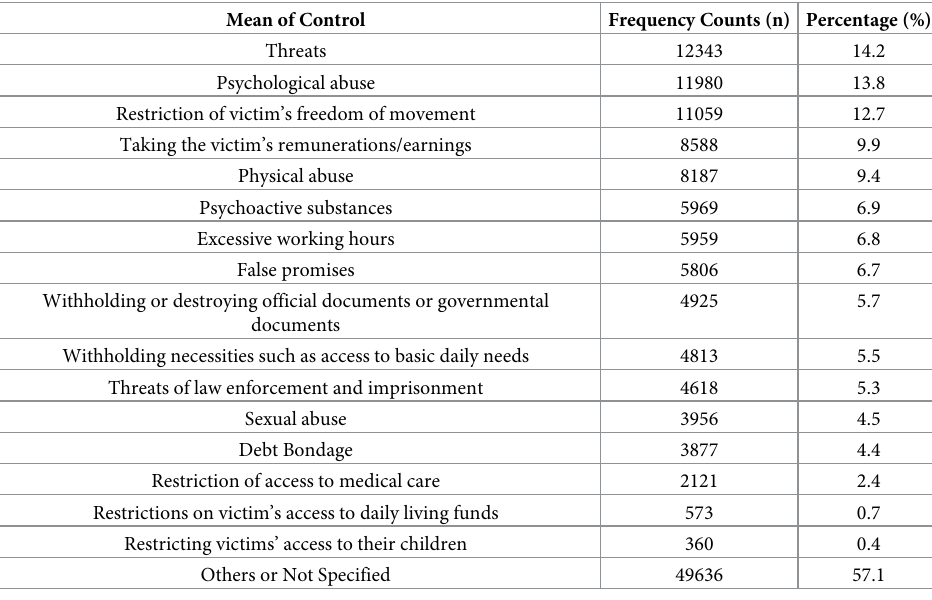
Table 2. Means of control of victims *